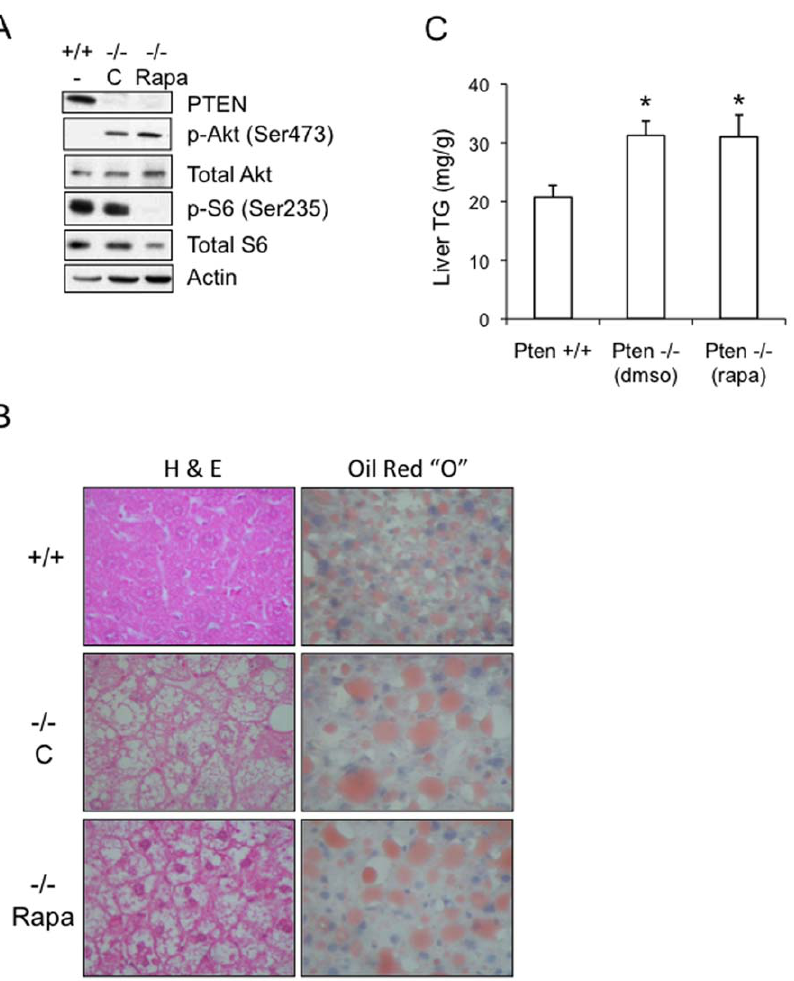
Figure 6. Effects of rapamycin on Pten 2 / 2 livers. Hepatocyte-specific deletion of Pten was generated by crossing Pten fl/fl with Cre Alb mice. At 12 weeks of age, Pten 2 / 2 mice were randomly assigned to treatments with rapamycin (2 mg/kg IP daily, M-F) or DMSO as vehicle control (C) for 2 weeks and then sacrificed. A) Representative Western blot showing the effects of Pten loss ( 2 / 2 ) and rapamycin (Rapa) in the liver with respect to Akt and mTORC1 signaling. Liver lysates were subjected to immunoblot analyses with the indicated antibodies. B) Liver histology (H&E) and Oil Red ‘‘O’’ staining of Pten + / + and Pten 2 / 2 mice treated with rapamycin or vehicle control. C) Quantification of liver triglyceride content of the corresponding groups. Values represent mean 6 SEM. *, p , 0.05 compared to Pten + / + group.